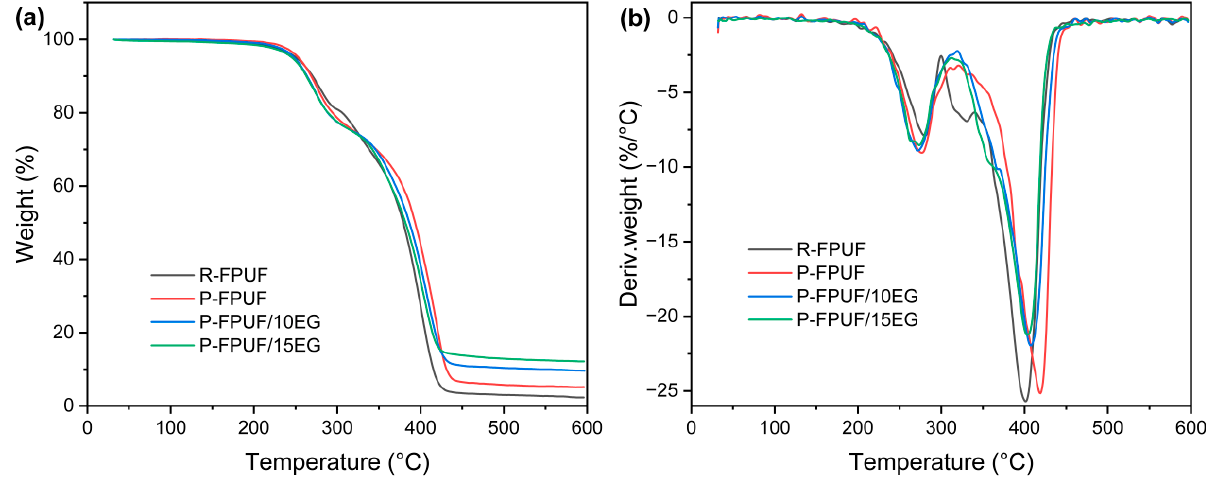
Figure 8. TGA ( a ) and derivative thermogravimetry (DTG) ( b ) curves for FPUFs at a heating rate of 20 °C/min in N ₂ .